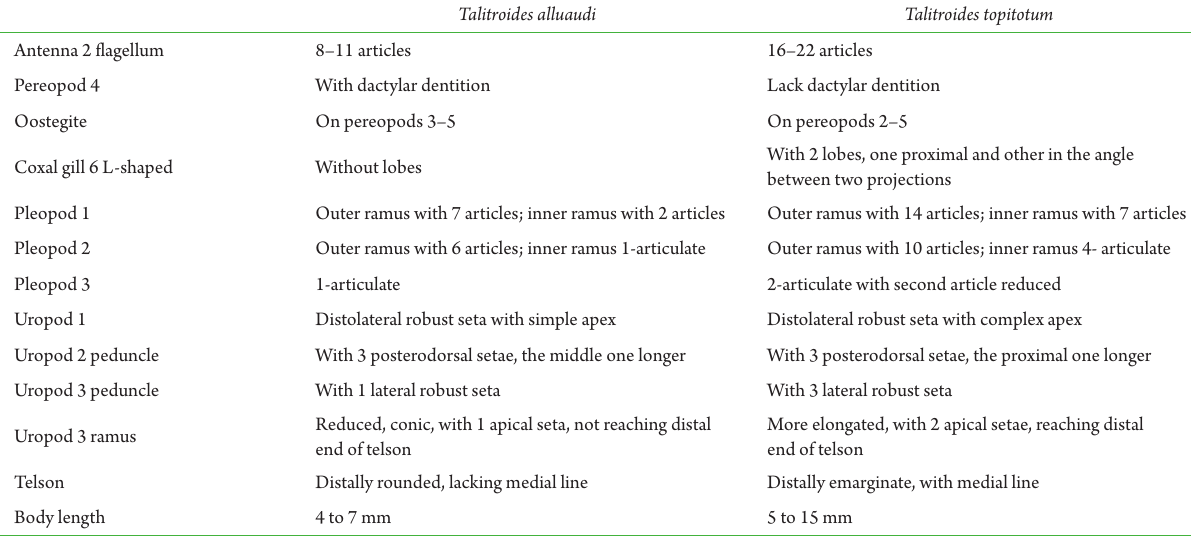
Figure 7. Distribution of Talitroides topitotum (Burt, 1934) (blue dots) and T. alluaudi (Chevreux, 1896) (red dots) based on samples from the Collection of Museu Nacional (MNRJ). States: MG, Minas Gerais; RJ, Rio de Janeiro; SP, São Paulo; PR, Paraná; SC, Santa Catarina; RS, Rio Grande do Sul. Table 2. Morphological differences between T. alluaudi (Chevreux, 1896) and T. topitotum (Burt, 1934) based on literature and observed